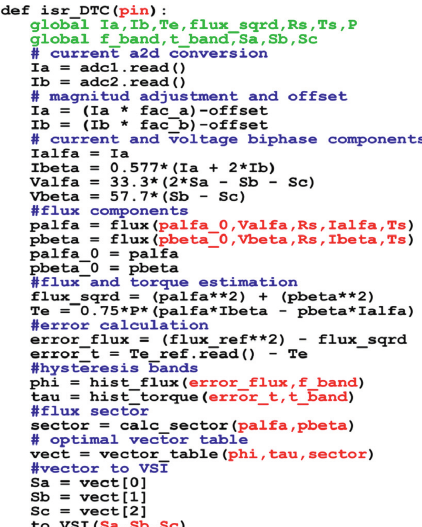
Figure 9: Micropython code example for the DTC interrupt service routine.